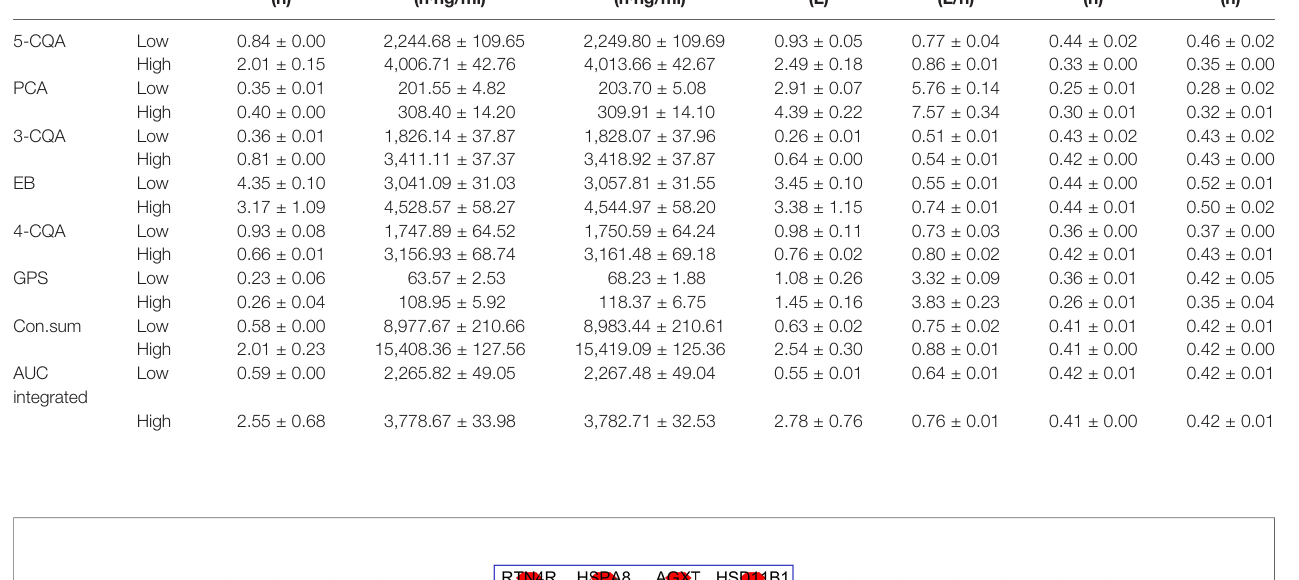
TABLE 1 | The pharmacokinetics (PK) parameters of the six ingredients in rat plasma after i.v. administration of Acanthopanax senticosus extract preparation (ASEP) (Mean ± SD, n=3).